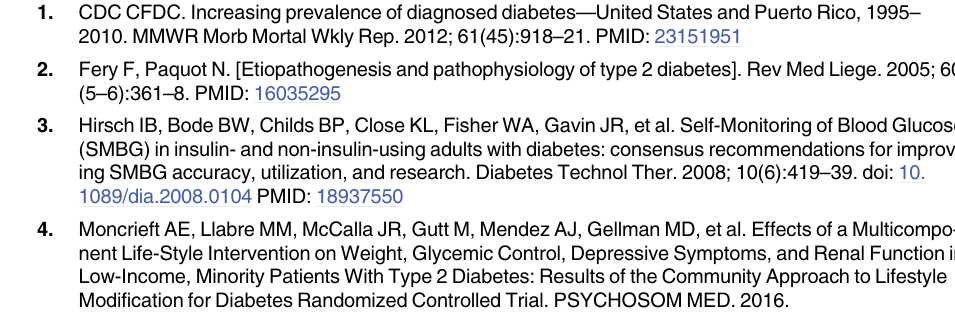
S1 Table. Search strategy for PubMed. S2 Table. Baseline of HbA1c. S3 Table. Risk of bias